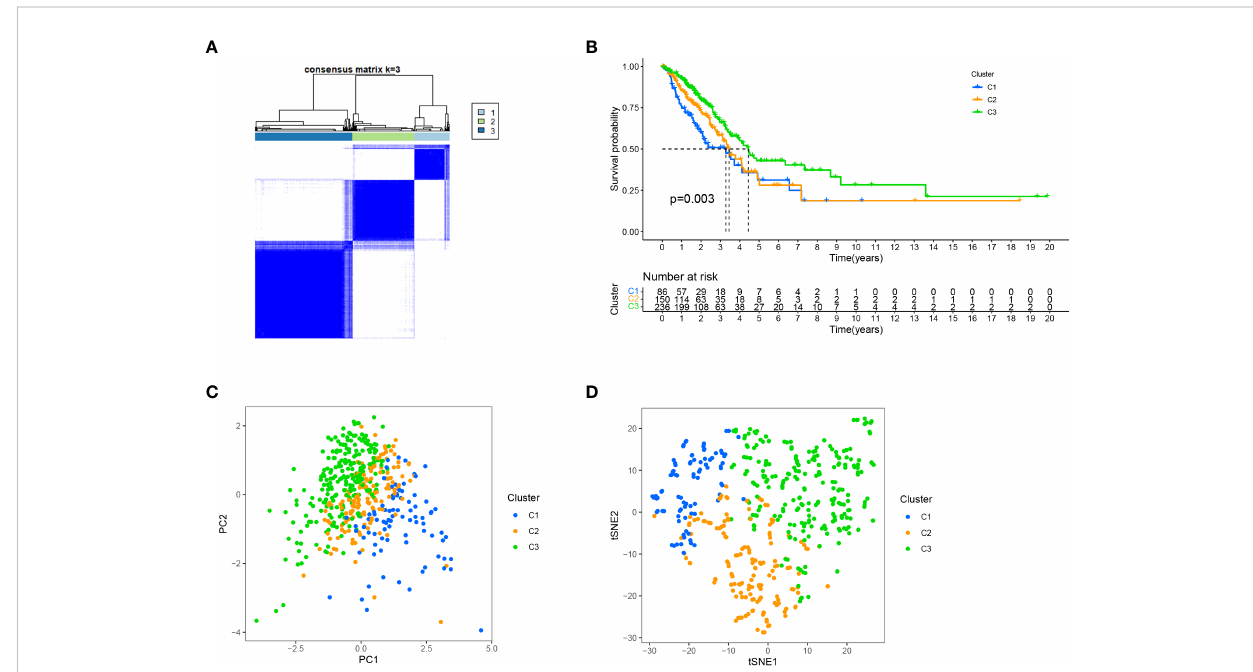
FIGURE 10 Distinguishing different clusters. (A) Patients are classi fi ed into three categories by ConsensusClusterPlus. (B) Kaplan-Meier survival curve in the three clusters. (C, D) PCA and t-SNE of three